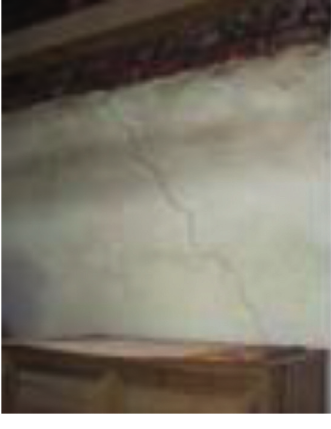
Figure 1: Wall cracks.